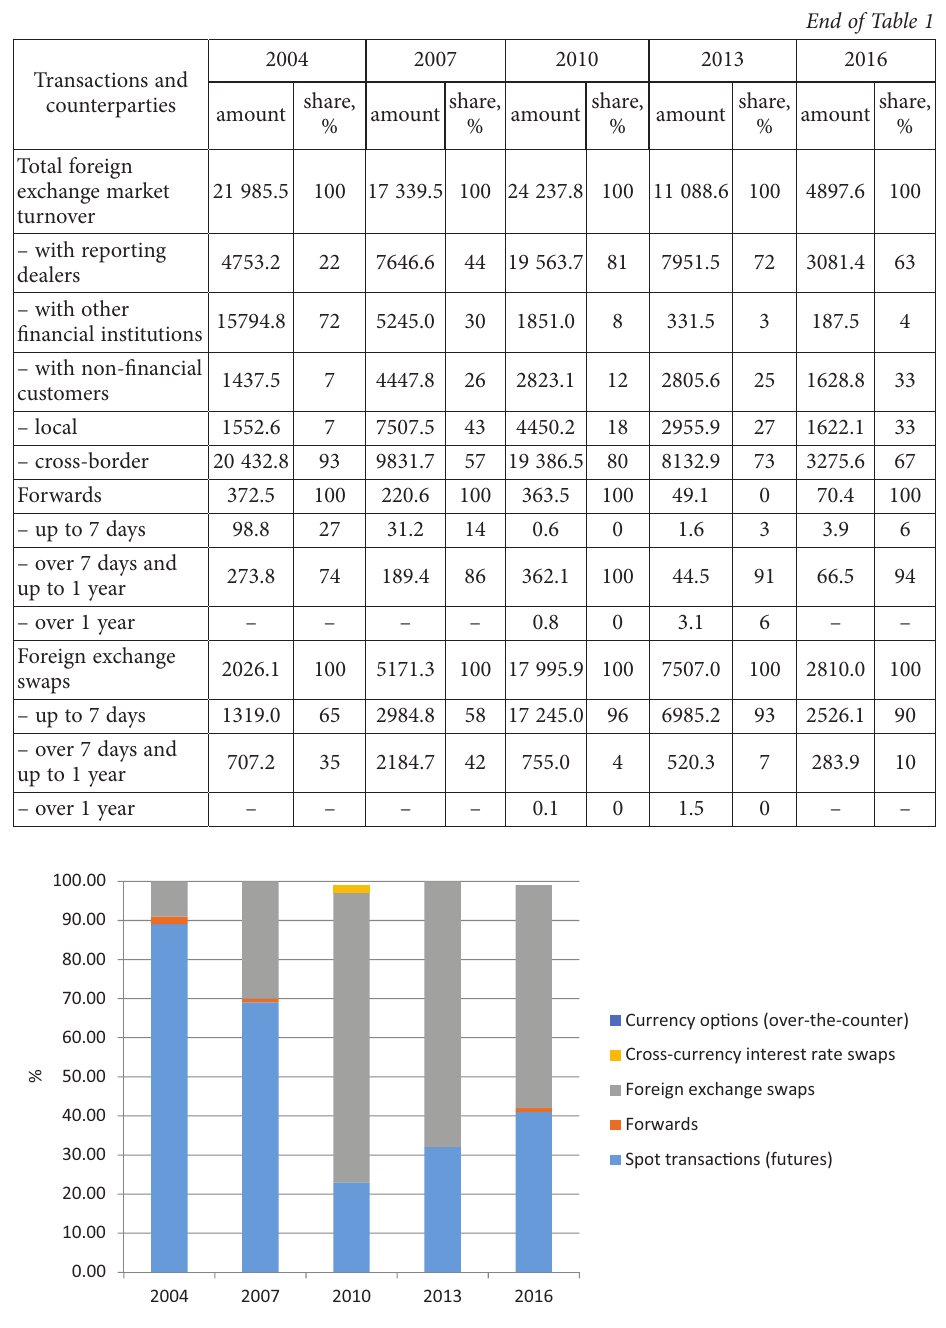
Figure 4. Total turnover by foreign exchange transactions in Lithuania in 2004–2016, in % (source: developed by the authors based on LB, 2016, 2018; BIS, 2018a, 2018b)